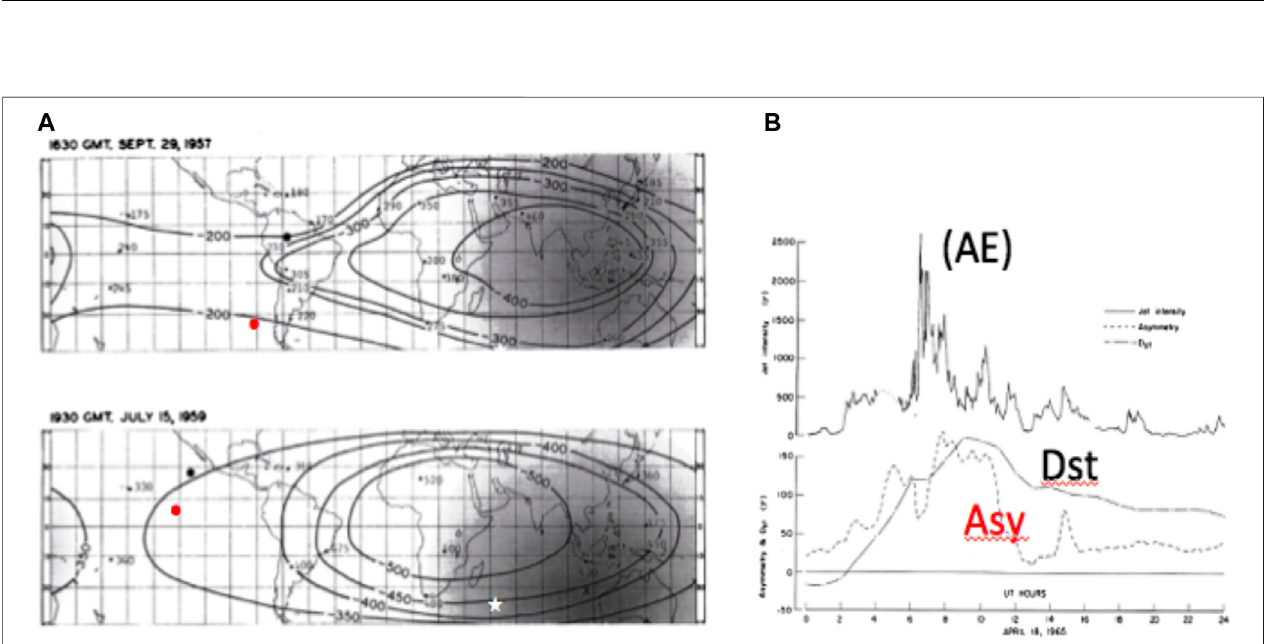
FIGURE 5 | A collection of magnetograms from low latitude stations; from the left African, the Middle East Asian and American sectors. In this case, the Asian stations had the largest main phase decrease, because they were located in the evening sector.